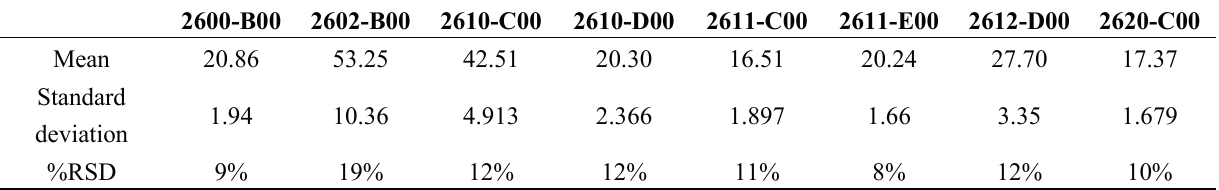
Table 6. Percent relative standard deviation (%RSD) of response of particular